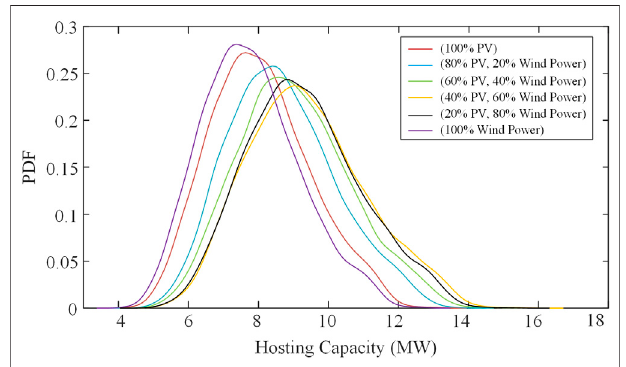
FIGURE 10 | PDF of the hosting capacity with different shares of wind and PV.